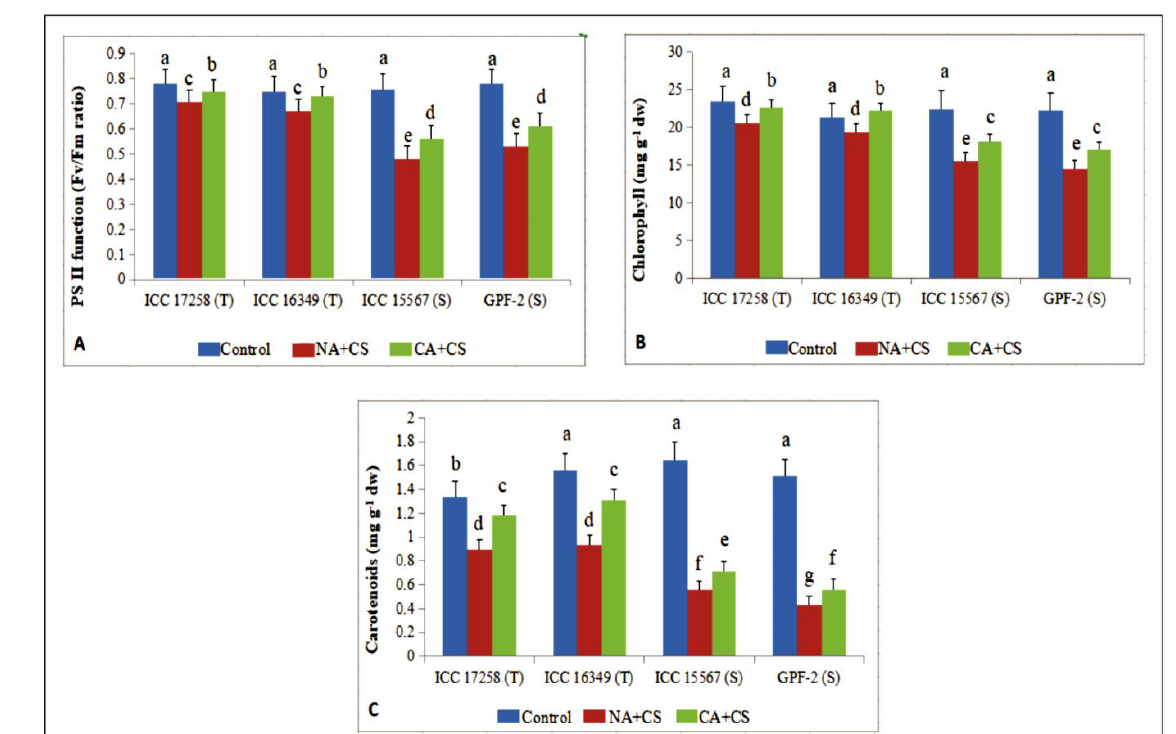
Figure 2. Membrane damage as electrolyte leakage (EL; ( A )), relative leaf water content (RLWC; ( B )) and stomatal conductance ( gS ; ( C )) in leaves of control, non-acclimated, cold stressed; NA + CS) and cold-acclimated, cold stressed (CA + CS) plants of tolerant (T) and sensitive (S) genotypes. Small vertical bars represent standard errors (Mean ± S.E; n = 3). Different small letters on vertical bars indicate significant differences from each other ( p < 0.05; Tukey’s test). Least significant difference (LSD) for interaction ( p < 0.05): (genotypes × treatments) EL (2.4), RLWC (3.1) and gS